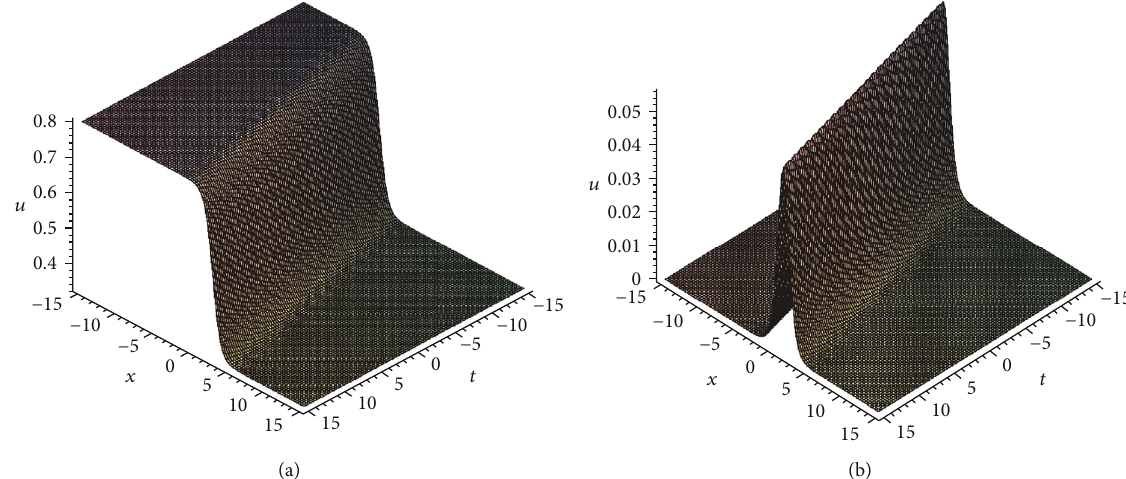
Figure 1: Plot (a) refers to the single kink solutions of u , and (b) refers to bell solitary wave of v in equation (26), with parameters: { c = 4/5, k = − 4/17, z 0 = 2